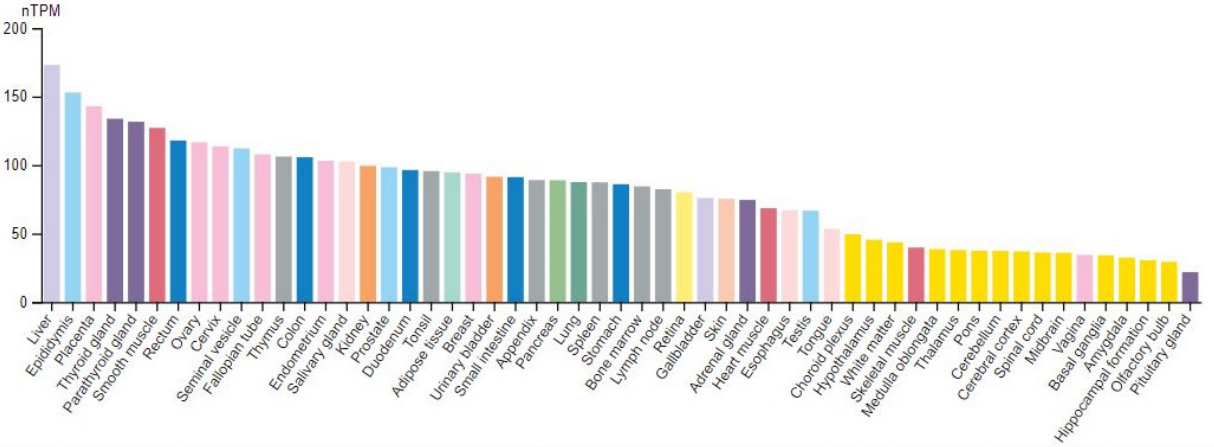
Figure 2. The human protein atlas of GANAB expression. nTPM normalized expression transcripts per million. (Figure reproduced from https://www.proteinatlas.org/ENSG00000089597-GANAB/tissue, accessed on 5 March 2022).